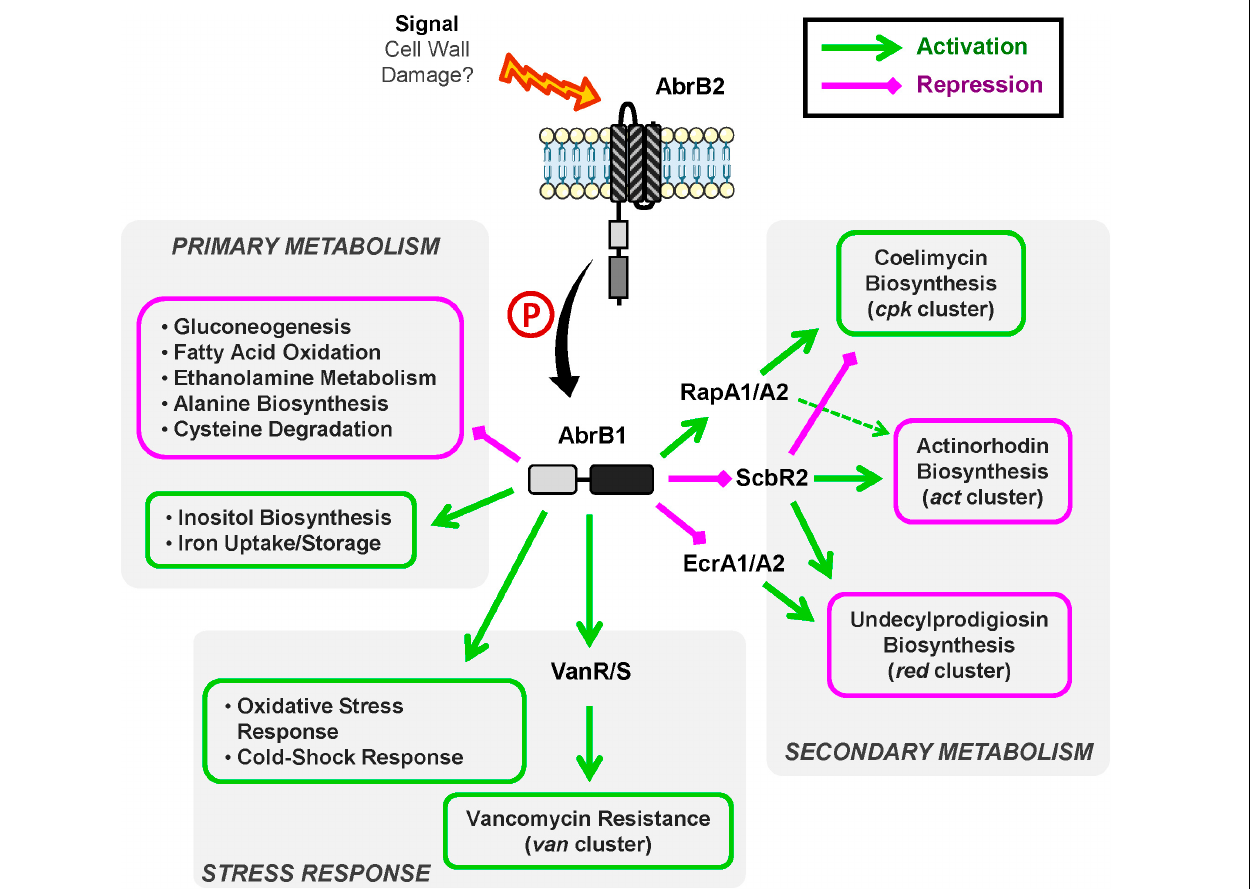
FIGURE 6 | Overview of AbrB1/B2 regulatory cascade. Summary of positively regulated processes (green) and negatively regulated processes (magenta) by the TCS